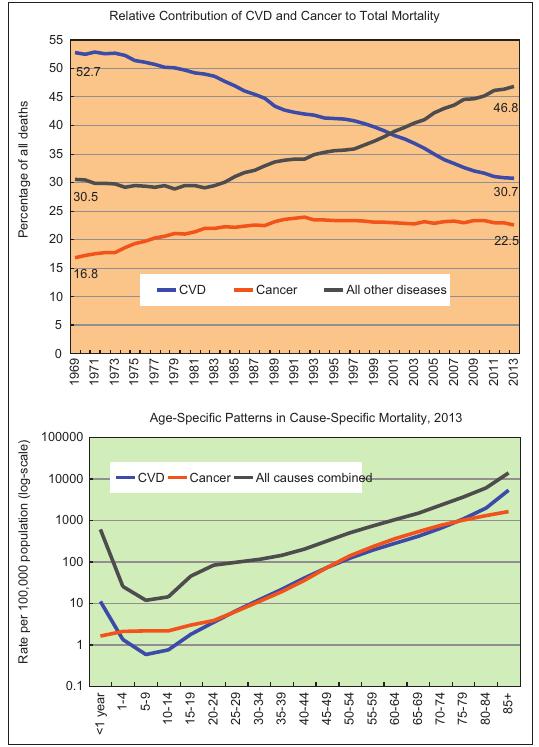
Figure 1 . Relative Contribution of Cardiovascular Disease (CVD) and Cancer to Overall Mortality and Age-Specific Pat